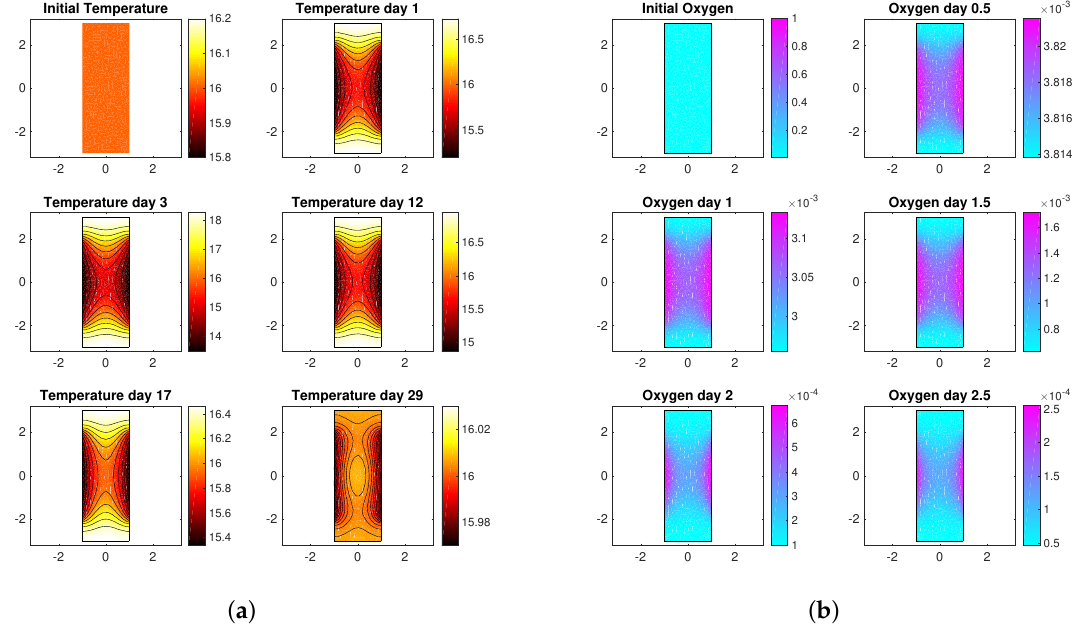
Figure 2. Model dynamics. ( a ) Temperature distributions throughout a section of the bioreactor during some phases of the fermentation process. ( b ) Oxygen gradients throughout a section of the bioreactor during some phases of the fermentation